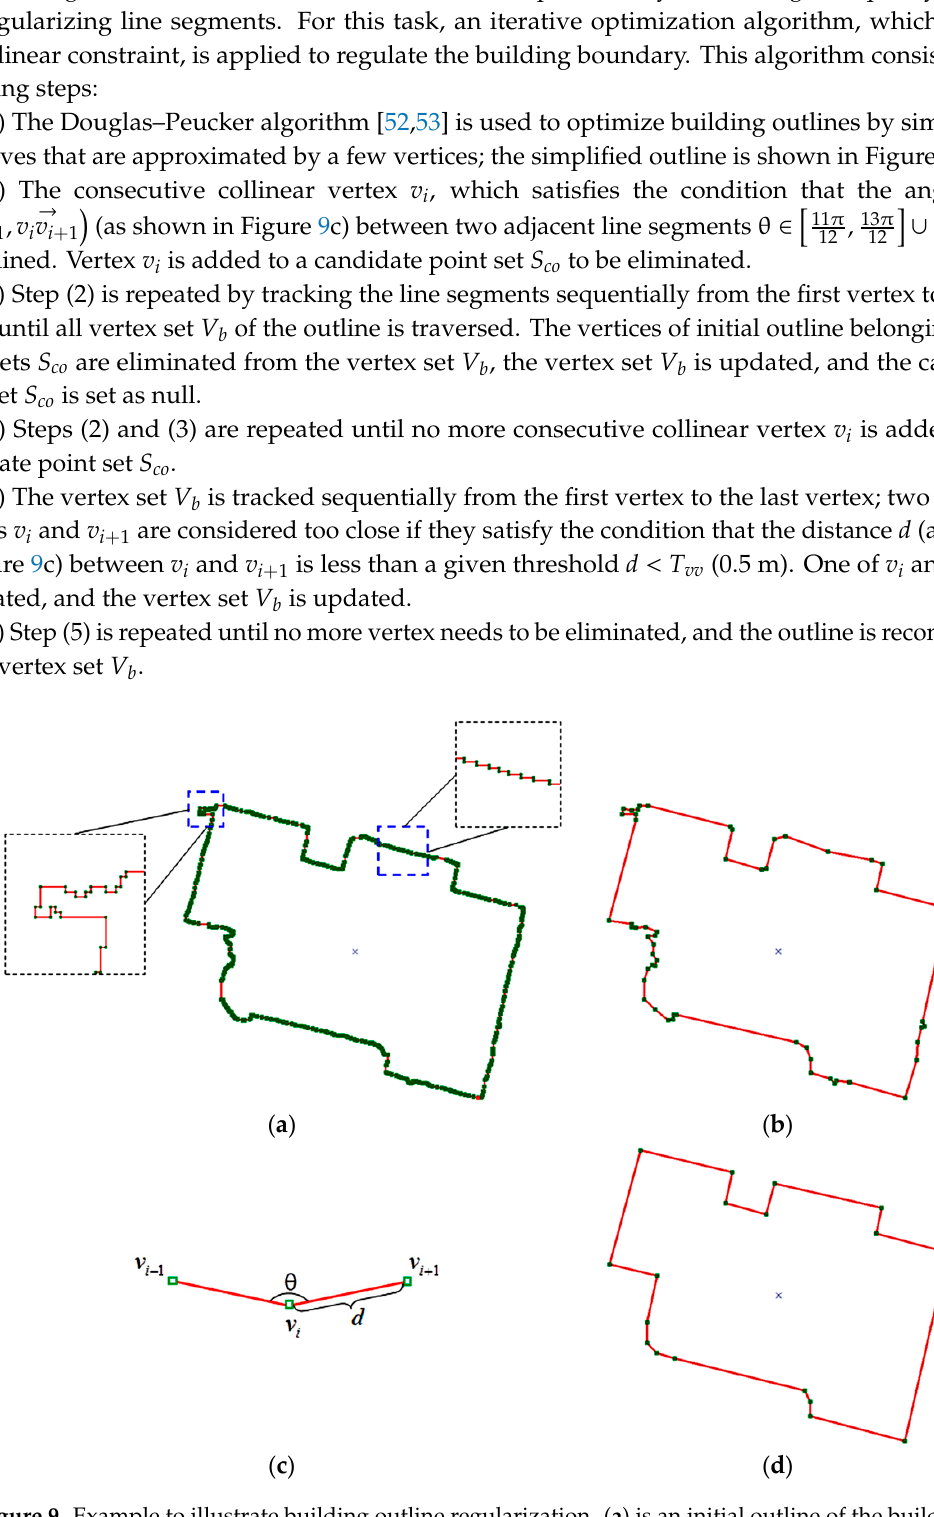
Figure 9. Example to illustrate building outline regularization. ( a ) is an initial outline of the building, with the red lines denoting the line segments and the green dots denoting the vertices. ( b ) is the simplified outline of the building using the Douglas–Peucker algorithm. ( c ) describes the angle of two line segments and the distance of two adjacent vertices. ( d ) is the regulated outline of building obtained from the proposed iterative optimization